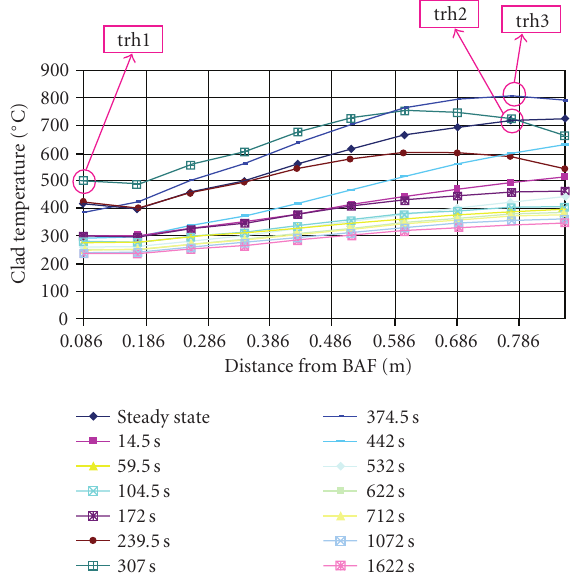
Figure 19: Temperature axial profile (LOFA—Hot Channel) with the points selected for the CFD simulations identified.